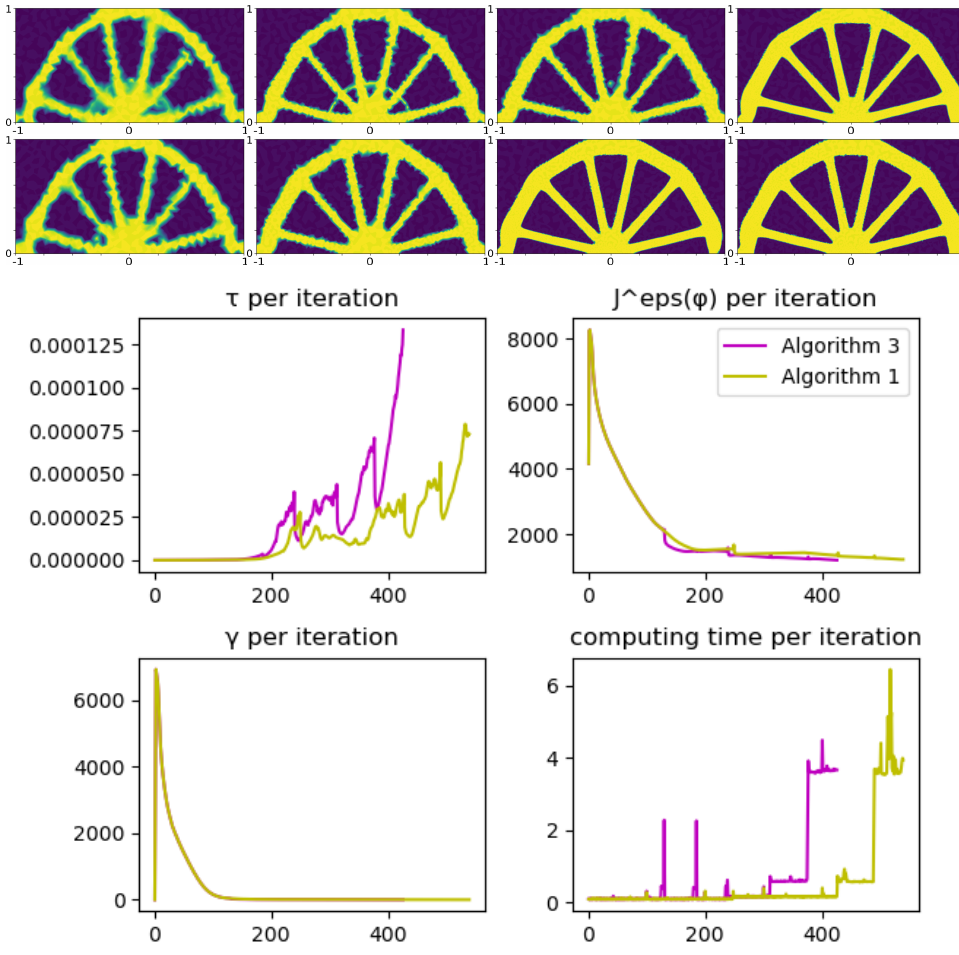
Figure 11. Comparison of ϕ 200 , ϕ 300 , ϕ 400 , ϕ n